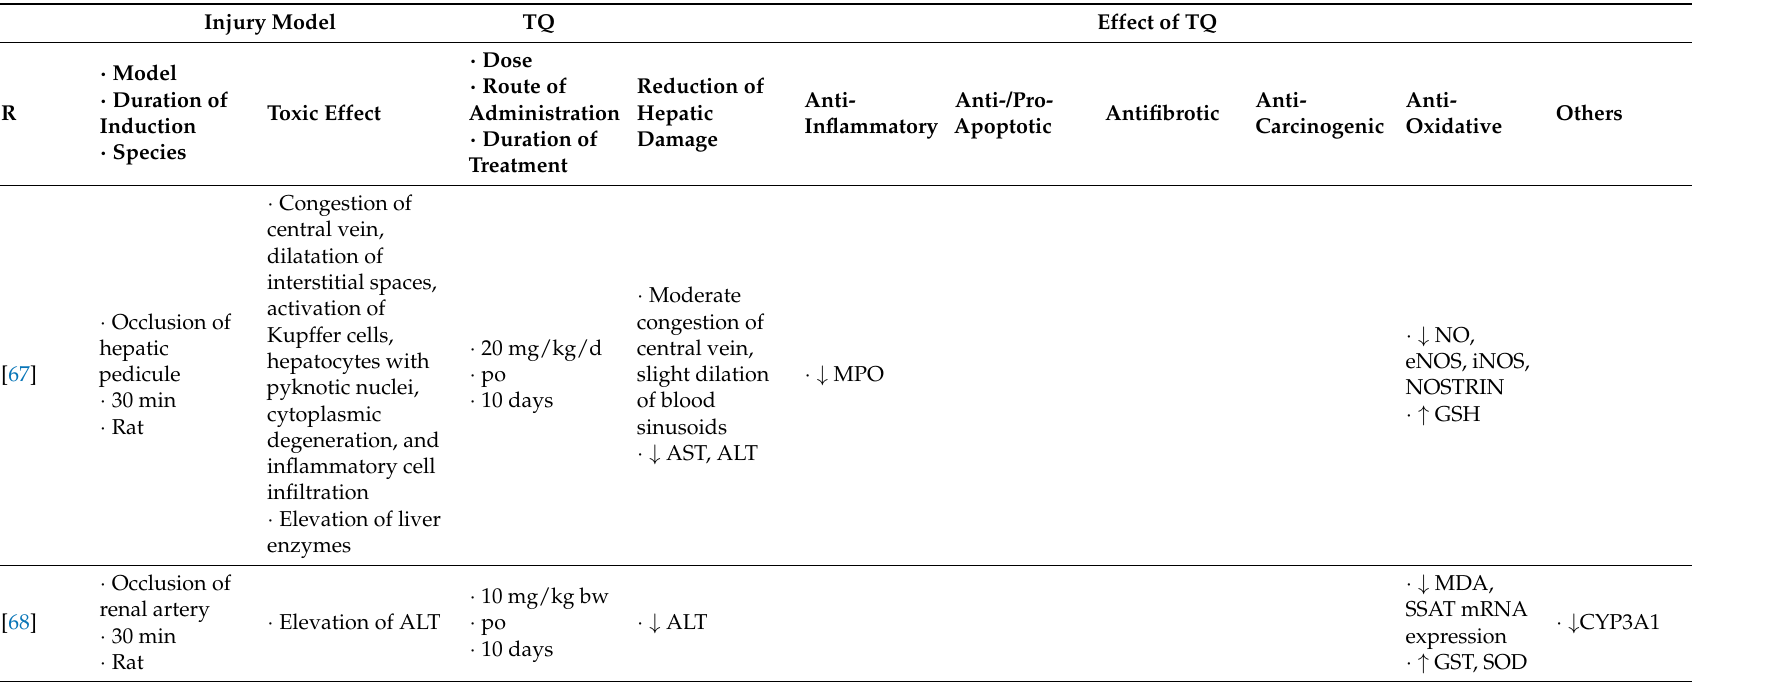
Table 8. Effects on liver injury caused by